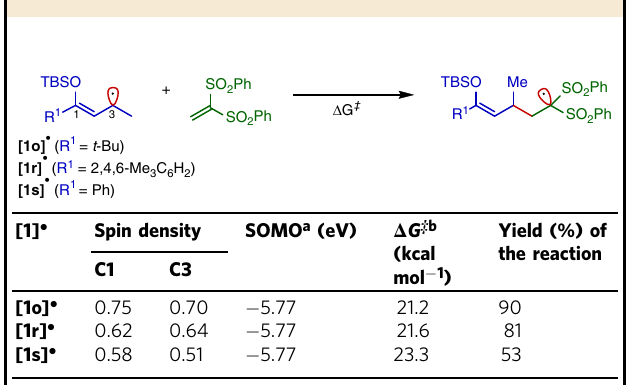
Table 2 Summary of spin density and SOMO level of the radicals [1] (cid:129) and activation barrier of their addition to